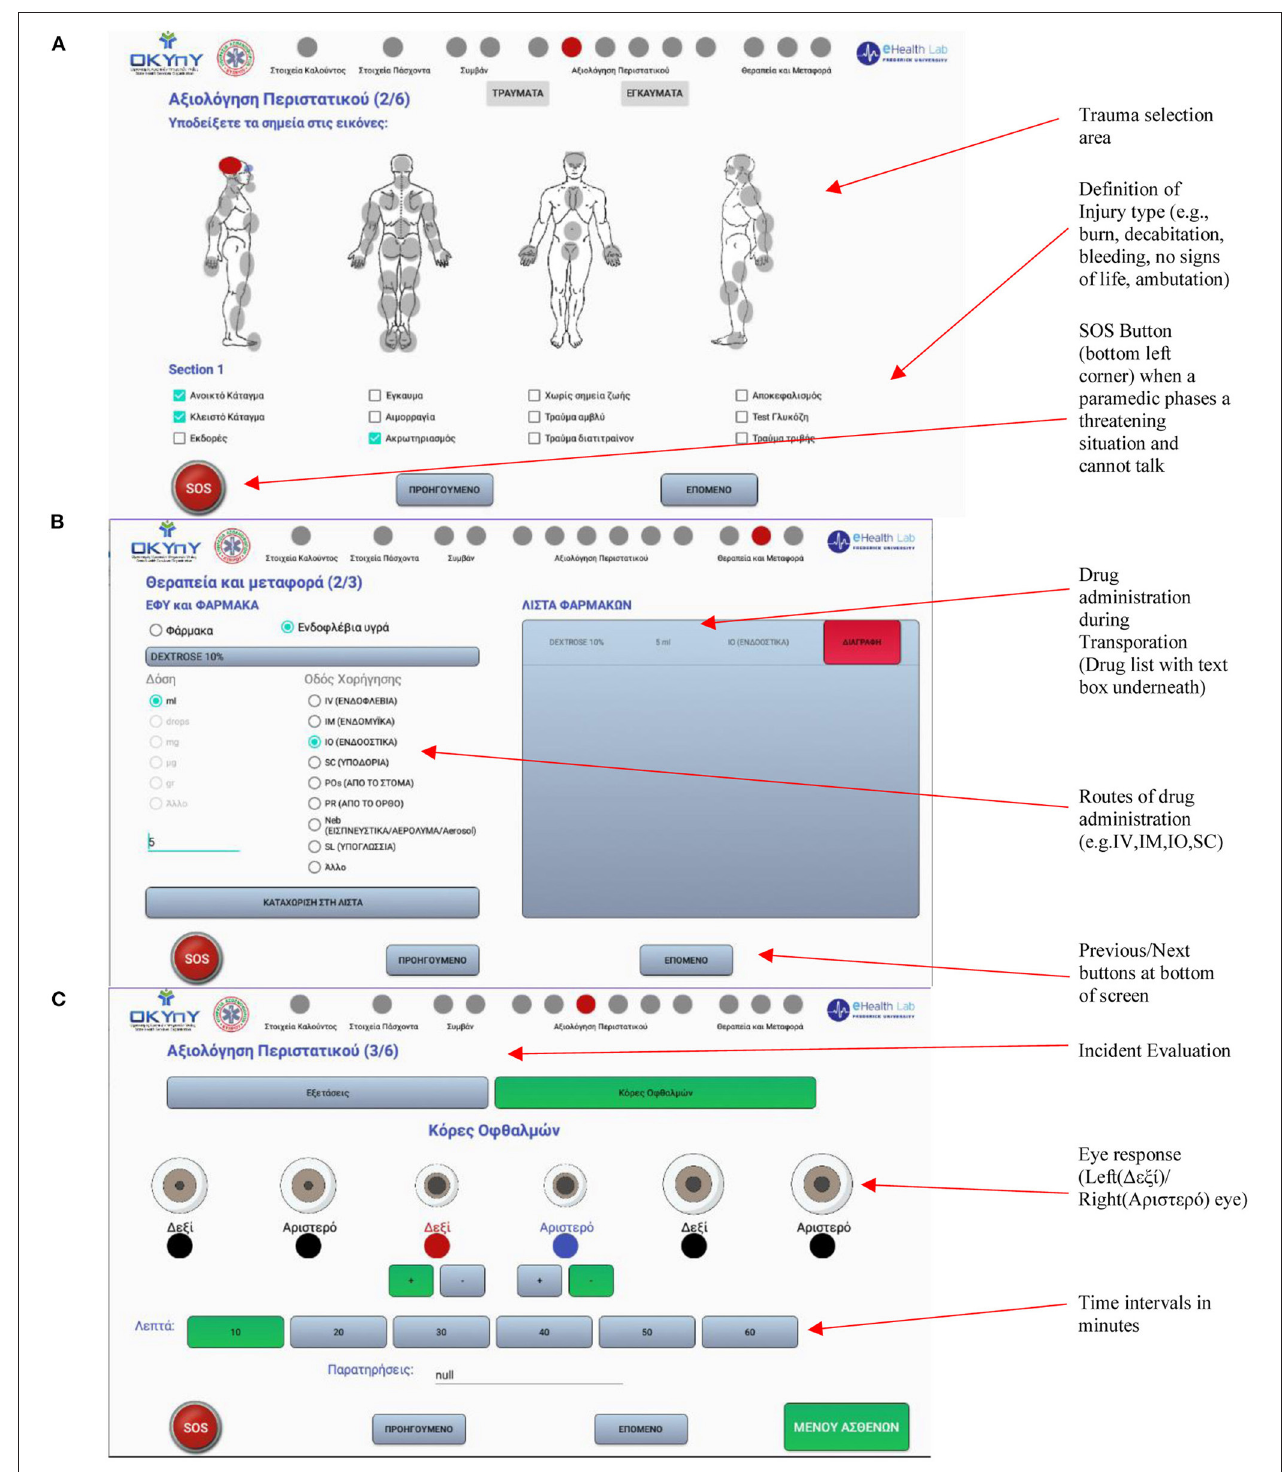
FIGURE 5 | Some of the key screenshots of the GUI used to record incident data (A) . Incident Evaluation for traumas (B) . Medicine administered during transportation (C) . Incident evaluation based on for eye response.